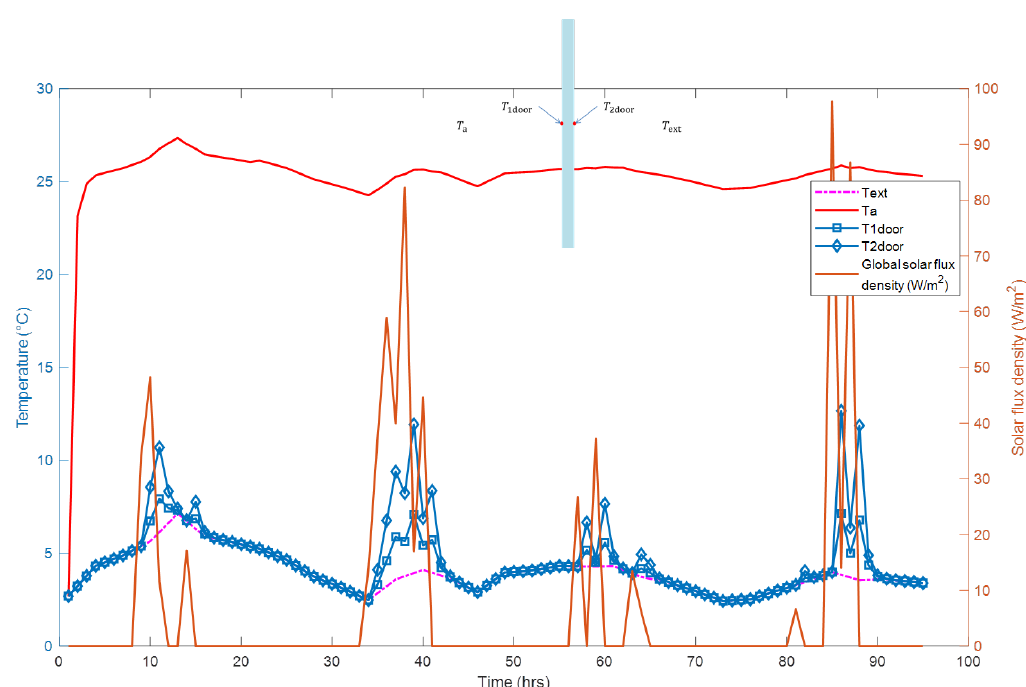
Figure 10 represents further layers of the wall temperature dynamics. As seen in the figure, the external temperature layer is more influenced by the solar radiation than the other sub-layers. That is because the wall is well insulated with 20 cm of polystyrene and Figure 9. Global solar radiation with ambient and door temperature dynamics profile. 10 cm of concrete.